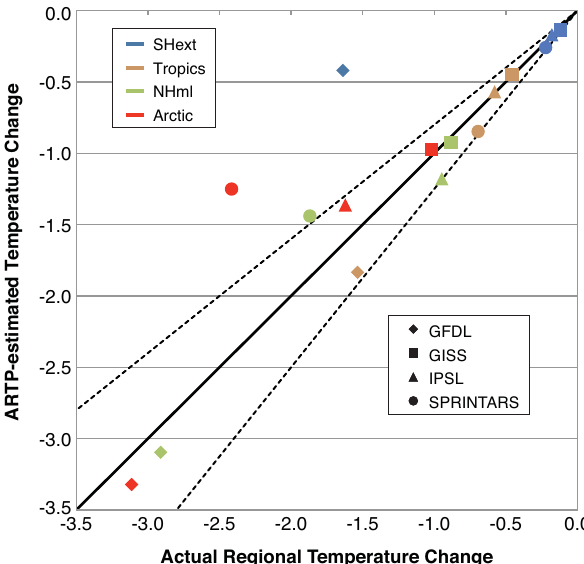
Fig. 1. Regional temperature changes in the indicated models (sym- bols) and regions (colors) from the actual simulations (horizon- tal axis) compared with the responses estimated using the forc- ing/response portion of the ARTP (vertical axis). Dashed lines show ± 20% agreement